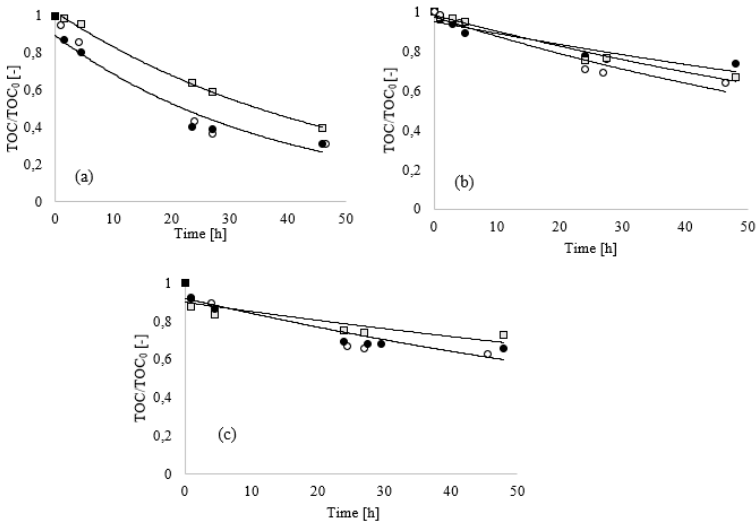
Figure 6. TOC removal trends (Blackman equation) during accelerated biodegradation tests of conditioning mixture A ( a ), B ( b ) and C ( c ) with 2.0 mL of Bacillus Clausii at different operative temperature as 4 ( □ ), 6 ( ○ ) and 8 ( ● ). Conditions: T = 30 °C and 0.10% as conditioning mixture dosage.